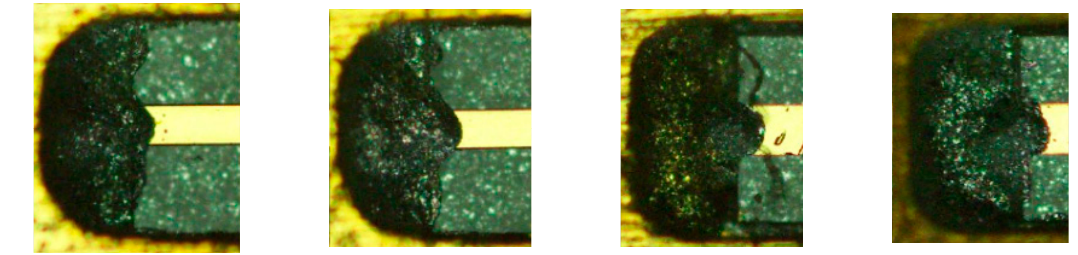
Figure 12. Assembling conductive adhesive of mixer 1 and mixer 2.